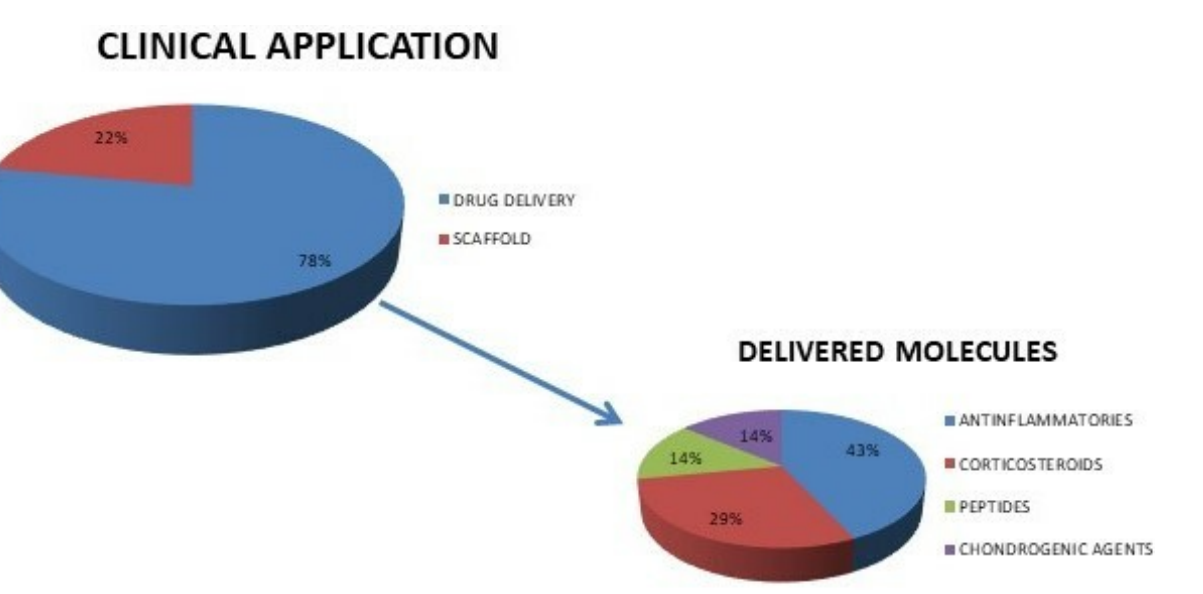
Figure 3. Diagrams of NPs-gel system clinical application and delivered molecules used in the included studies.